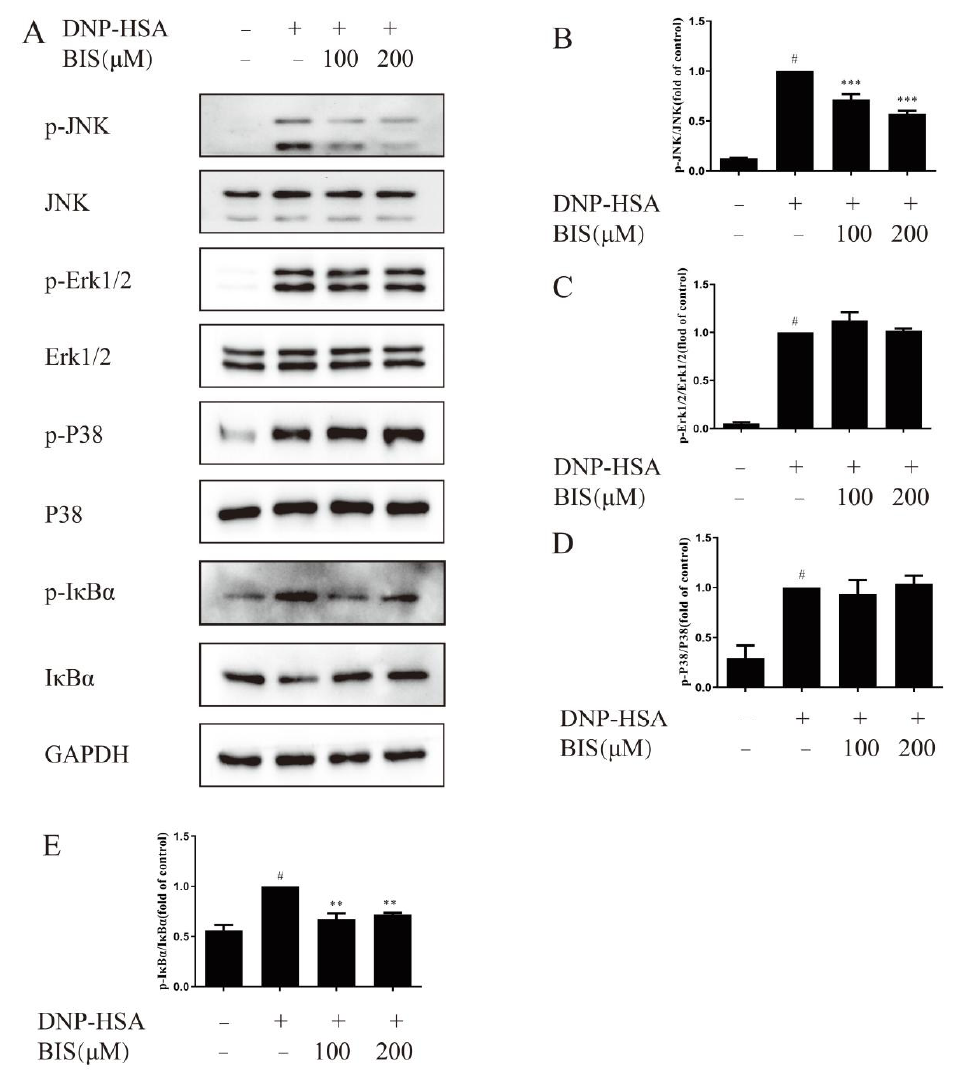
Figure 7. Effect of BIS on MAPK and NF- κ B signaling pathways in IgE/Ag-stimulated BMMCs. Cells were sensitized with IgE overnight and incubated with or without BIS for 30 min. Then, cells were stimulated with DNP-HSA for 15 min. Cell protein expression was detected and analyzed by western blotting. ( A ) The expression of phosphorylation of JNK, Erk1/2, P38, and I κ B α and JNK, Erk1/2, P38, and I κ B α were determined with western blotting. Densitometric analysis of p-JNK/JNK ( B ), p-Erk1/2/Erk1/2 ( C ), p-P38/P38 ( D ), and p-I κ B α /I κ B α ( E ). Data represent the mean ± SEM, n = 3. # p < 0.05 vs. Control; ** p < 0.01, *** p < 0.001 vs. Model.